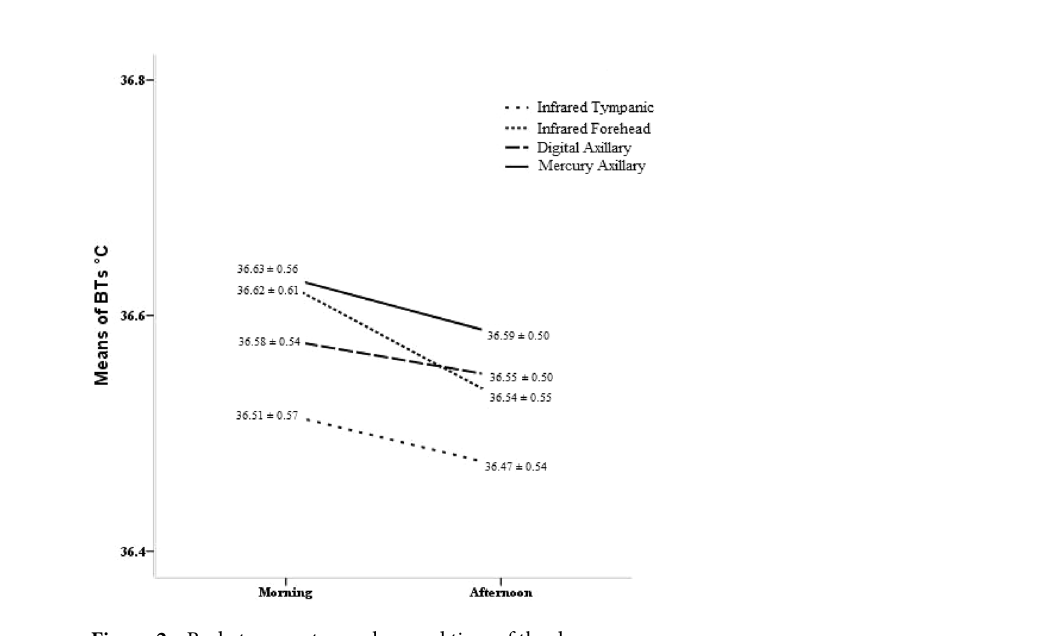
Figure 2. Body temperature values and time of the